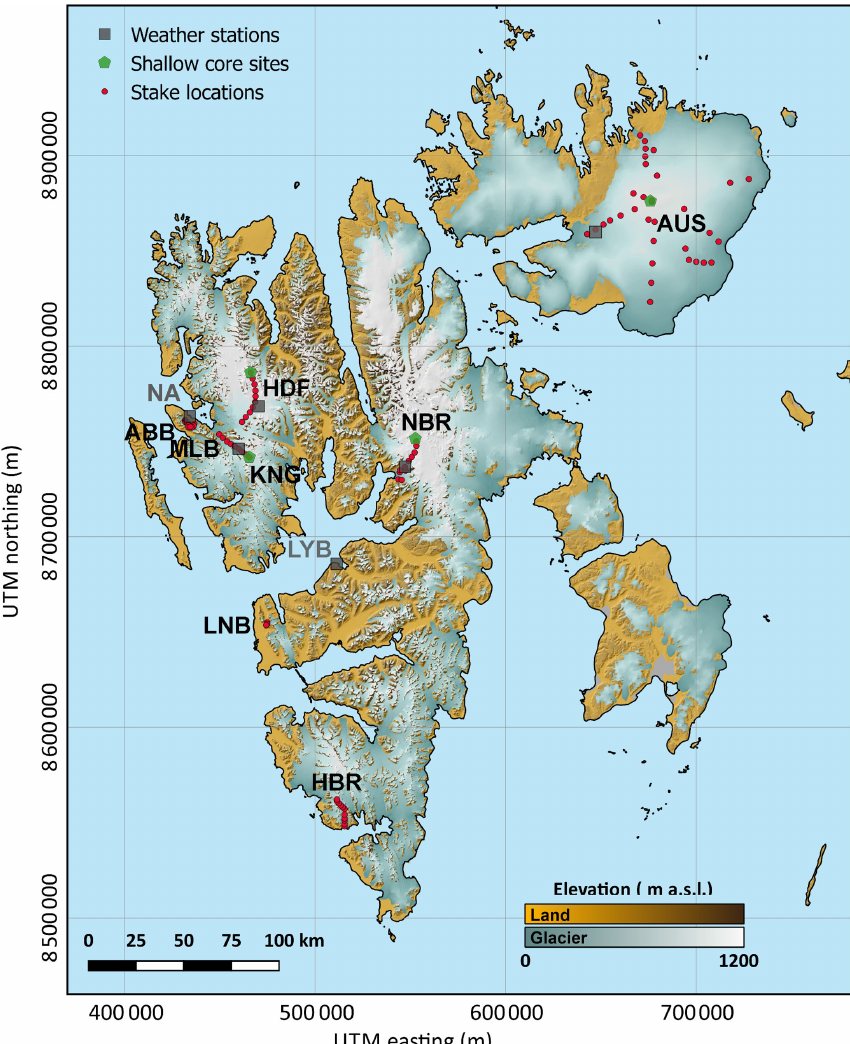
Figure 1. Topographic map of Svalbard with different elevation colour maps to distinguish between glacier-covered and land areas. Sites of in situ data collection, including stakes, weather stations, and shallow ice cores, are indicated (ABB: Austre Brøggerbreen; AUS: Austfonna; HBR: Hansbreen; HDF: Holtedahlfonna; KNG: Kongsvegen; MLB: Midtre Lovénbreen; LNB: Linnébreen; NBR: Nordenskiöldbreen; LYB: Longyearbyen; NA: Ny-Ålesund). UTM coordinates in this and later figures are in zone 33 X. The digital elevation model and mask used to produce the map are described in Sect. 2.1, and an overview of the observational data is given in Table